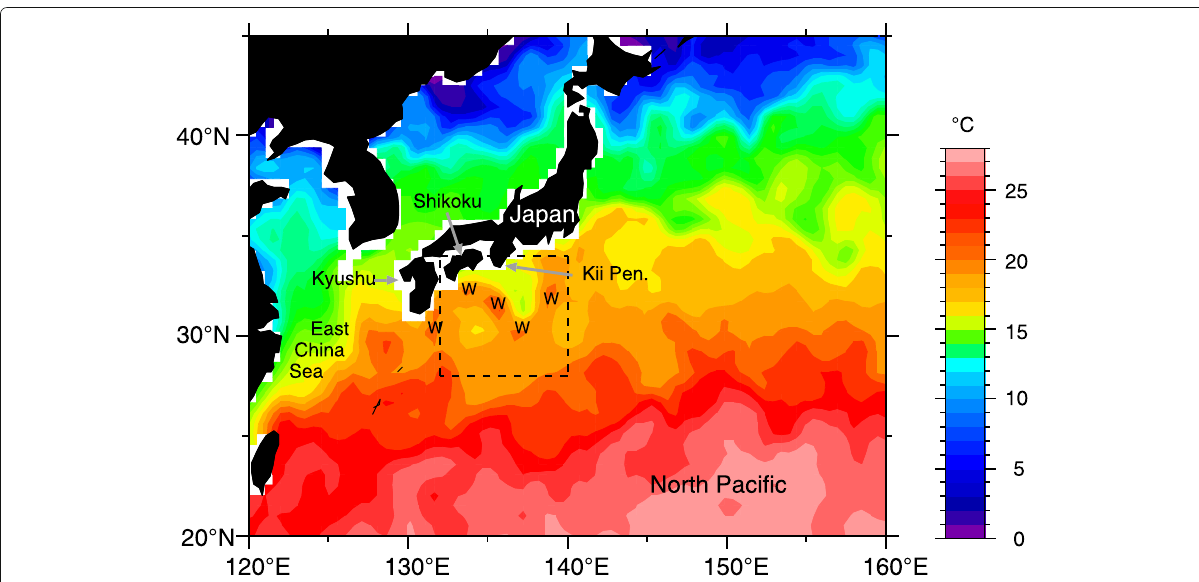
Fig. 1 Satellite-derived sea surface temperature map on January 1, 2019. Saildrone observations were performed in the region enclosed by the dashed square. The areas labeled with the letter W indicate anomalously warm spotty sea surface Kuroshio water